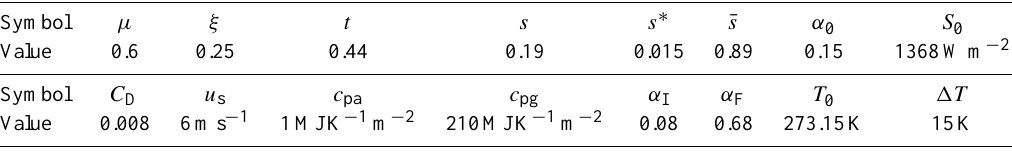
Table 1. Values for the parameters of the 0D model (radiative coefficients, bulk aerodynamic formula parameters and ice-albedo feedback parameterization). Note that the values for the heat capacities depend on the thickness of the layer and on the nature of the surface (ocean or land), but this has no influence on the steady-state results.